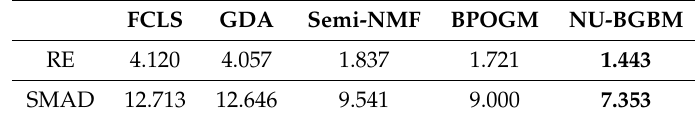
Figure 12. RSS maps of FCLS for the Urban real HSI, and the difference RSS maps between FCLS and GDA, semi-NMF, BPOGM, and NU-BGBM respectively. Table 4. Comparison of REs ( × 10 − 2 ) and SMADs ( × 10 − 2 ) of different methods using extracted endmembers for the Urban real